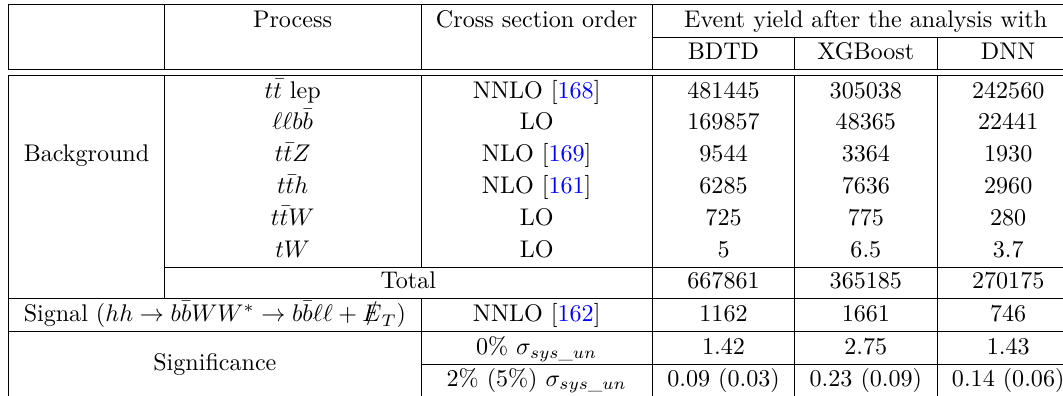
Table 5 . The signal and background yields at the HE-LHC along with the signal significance for the b ¯ bWW ∗ channel from the analysis using BDTD, XGBoost and DNN classifiers.